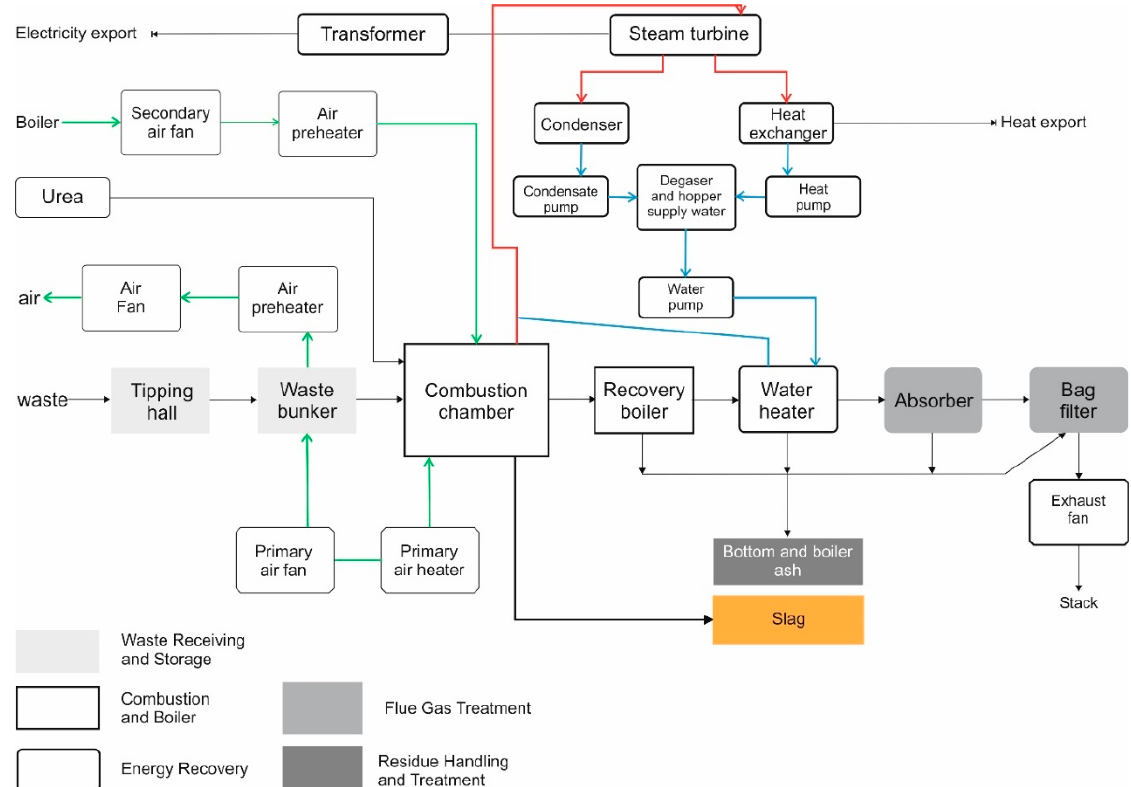
Figure 1. Simplified scheme of an analysed MSWI 1 incinerator.